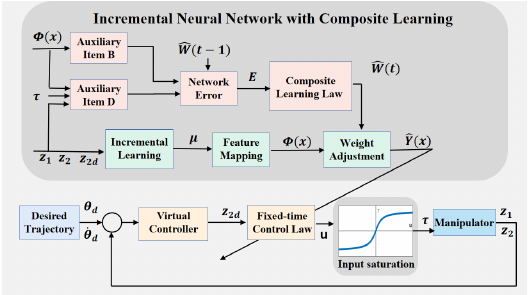
Figure 2. The overview of the proposed control